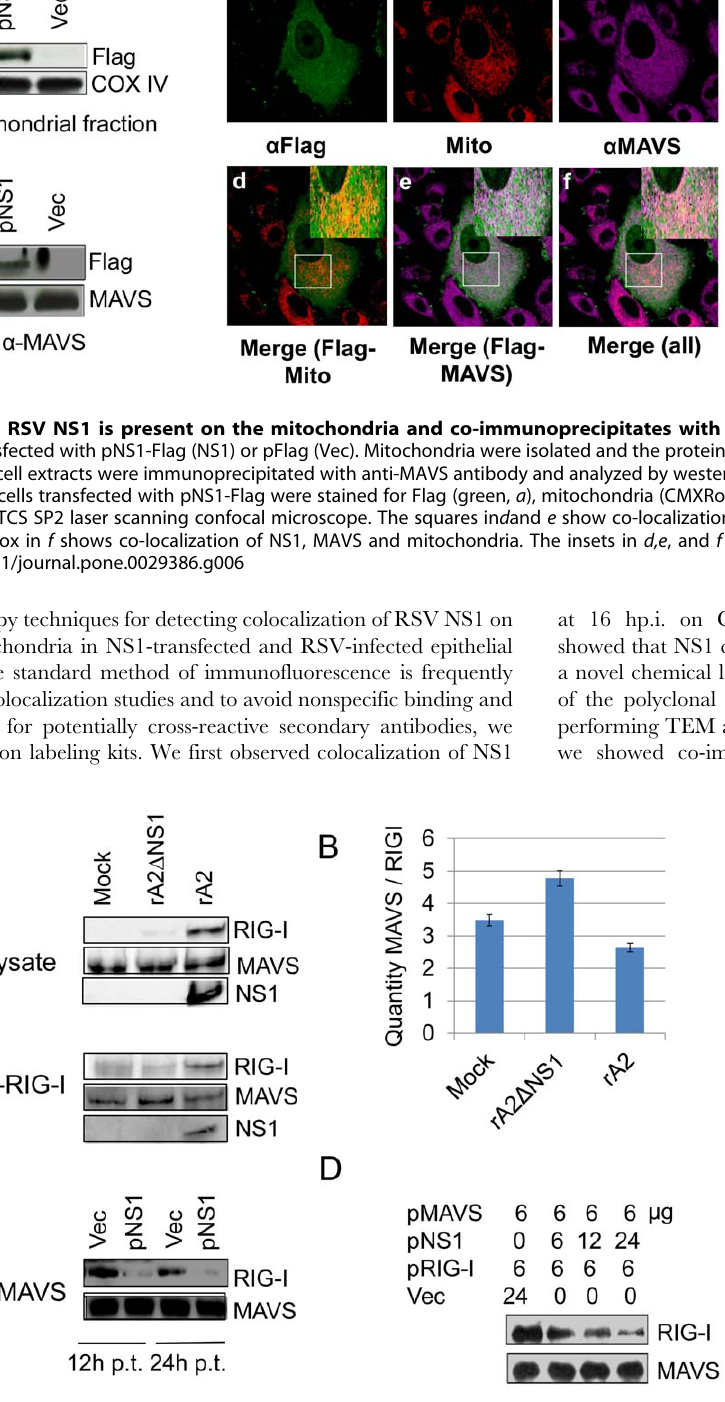
Figure 7. NS1 protein prevents RIG-I from binding to MAVS. ( A ) A549 cells were mock-infected or infected with rA2 or rA2 D NS1 (MOI=1). Whole-cell lysates were subjected to western blot analysis with anti-RIG-I, anti-MAVS, and anti-NS1antibodies ( top panel ). The same lysates were immunoprecipitated with anti-RIG-I antibody and the protein complexes were immunoblotted with the indicated antibodies ( bottom panel ). ( B )The bar graph represents the densitometric quantification of the band intensities as the ratio of MAVS to RIG-I. ( C ) A549 cells were transfected with the indicated plasmids (12 m g of either pVAX or pNS1) and incubated with 0.2 ng/ml poly (I:C). Cytoplasmic extracts from cells 12 and 24 h after transfection were immunoprecipitated with anti-MAVS and immunoblotted with anti-RIG-I antibody. ( D ) Increasing amounts of pNS1 were co- transfected with constant amounts (6 m g) of pMAVS and pRIG-I, along with 0.2 ng/ml poly (I:C). Competitive inhibition of the interaction of MAVS with RIG-I was tested using IP, as described in ( C ). Transfection with pVAX was used to keep the total amount of transfected DNA